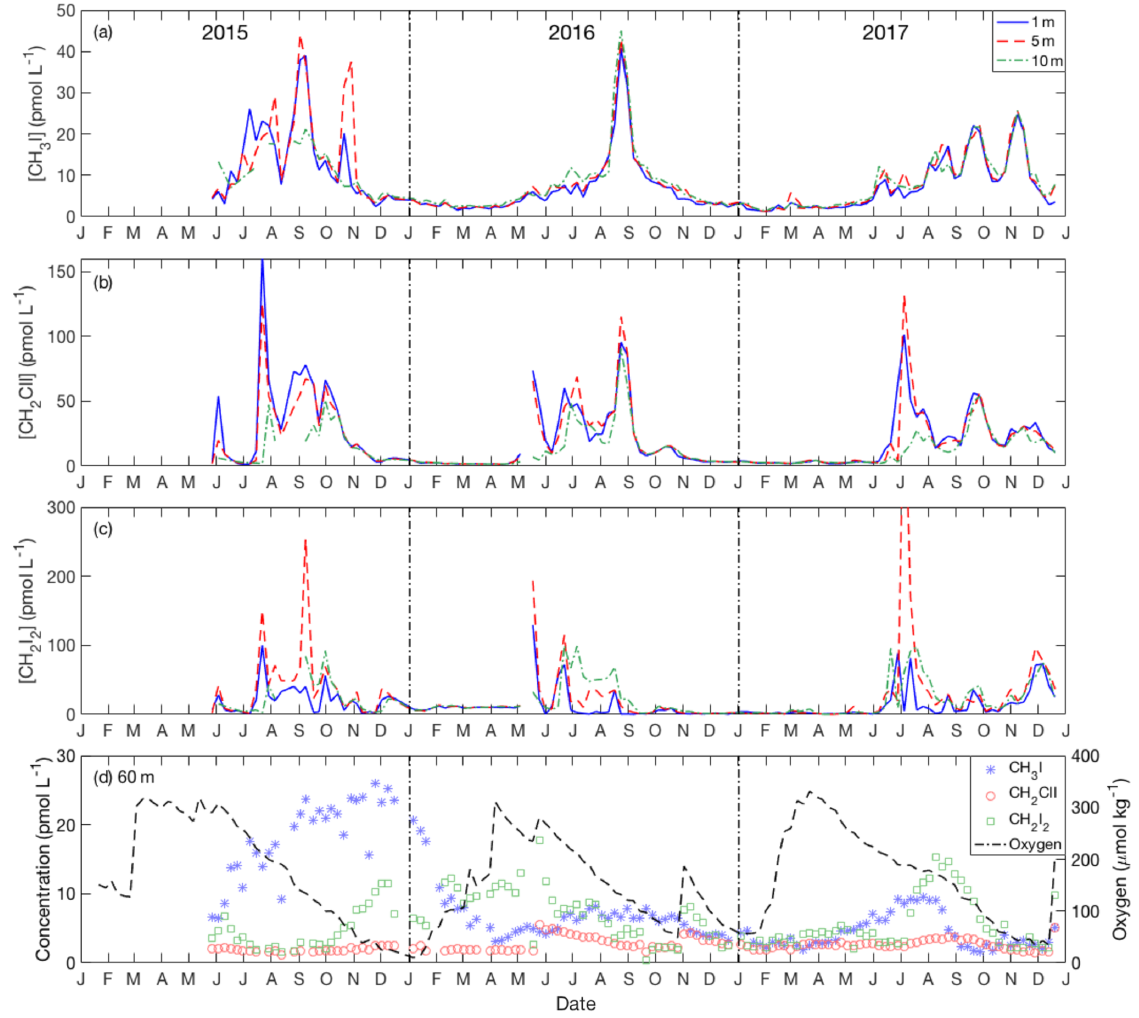
Figure 4. Seasonal variation of iodocarbons in the Bedford Basin at 1m (blue line), 5m (red line) and 10m (green line) from May 2015 to December 2017: (a) CH 3 I, (b) CH 2 ClI and (c) CH 2 I 2 . (d) Time series from near-bottom water (60m) of iodocarbons and dissolved oxygen.